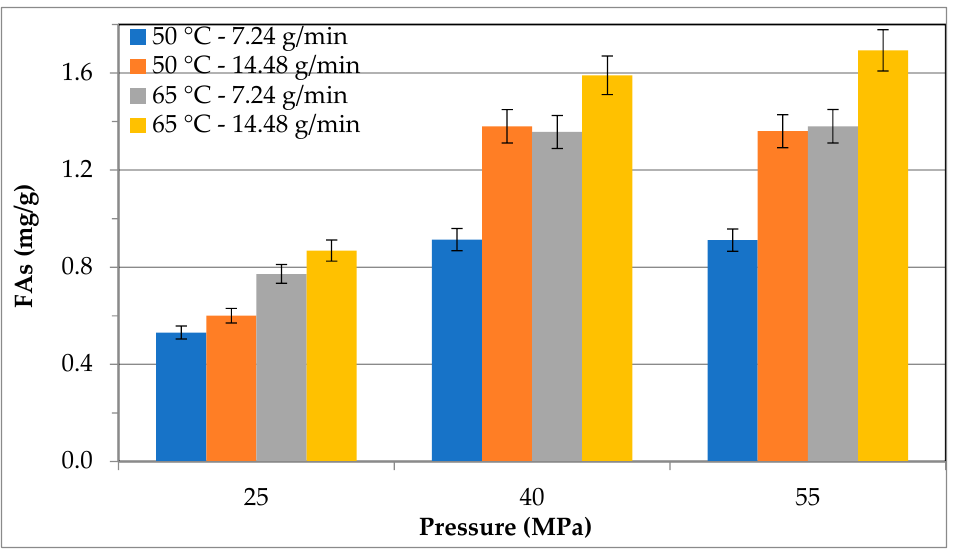
Figure 4. Influence of SF-CO 2 extraction on fatty acid extraction yield.